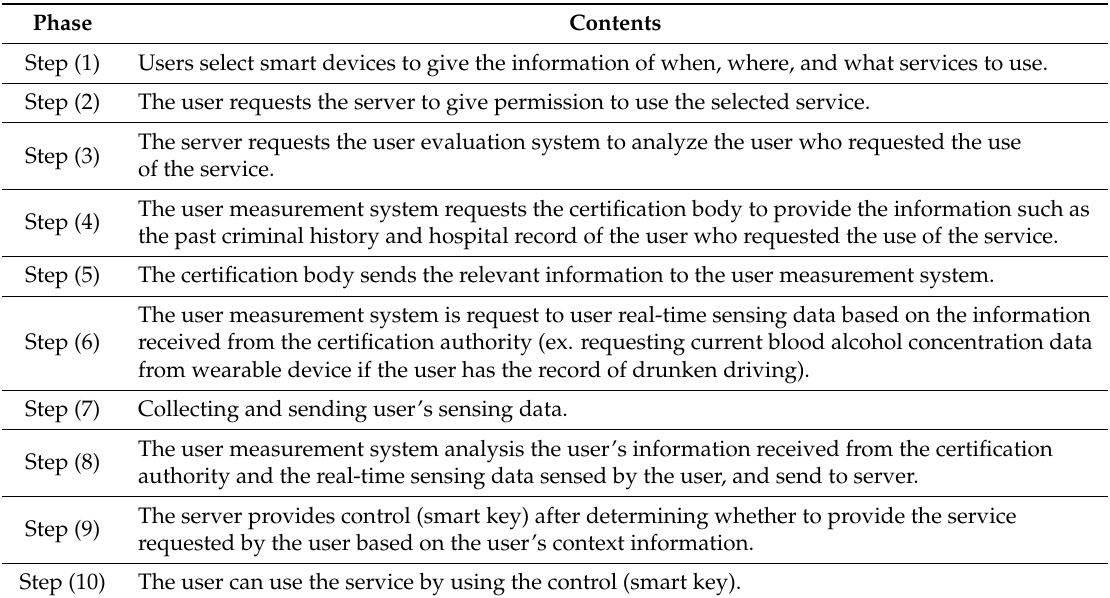
Table 1. Procedure for measuring user’s reliability.